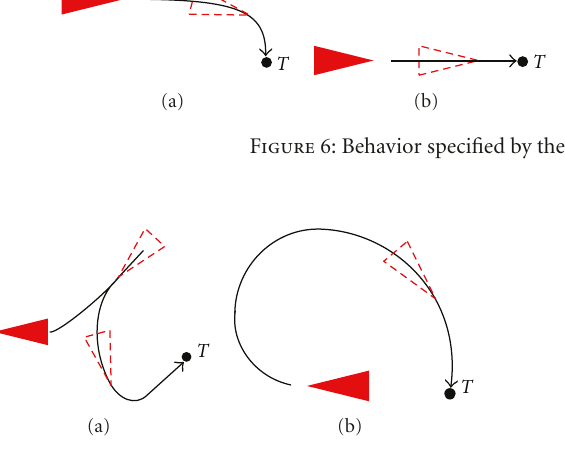
Figure 7: Behaviors specified by a reference vector field that biases forward motion (a), and uses only forward motion (b).